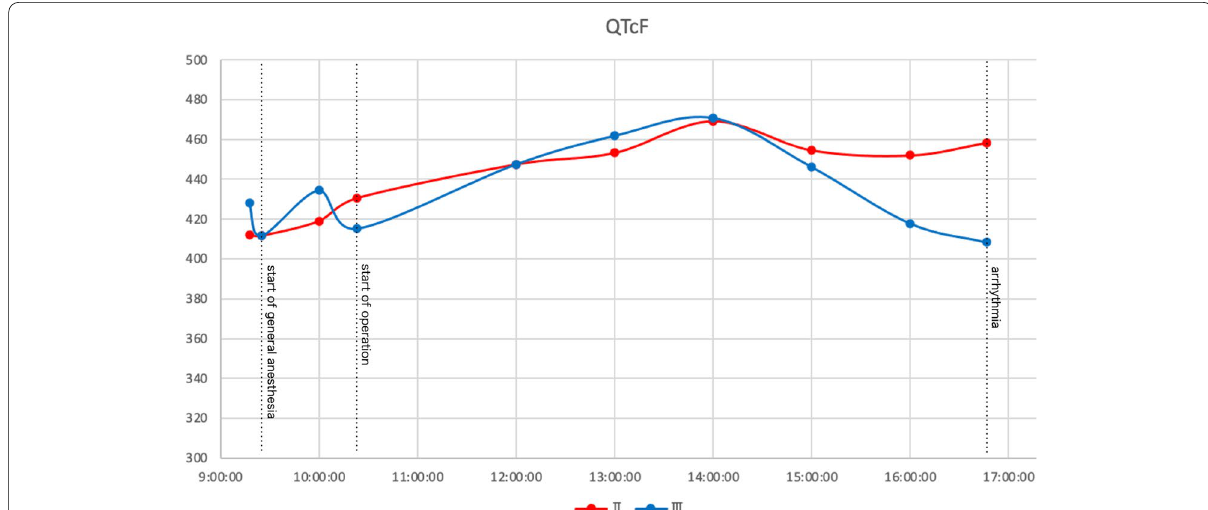
Fig. 2 Time course of QTc of leads II and III. The difference of QTcF between leads II and III increased in the latter half of the recording and reached 50 ms of difference just before the onset of the ventricular